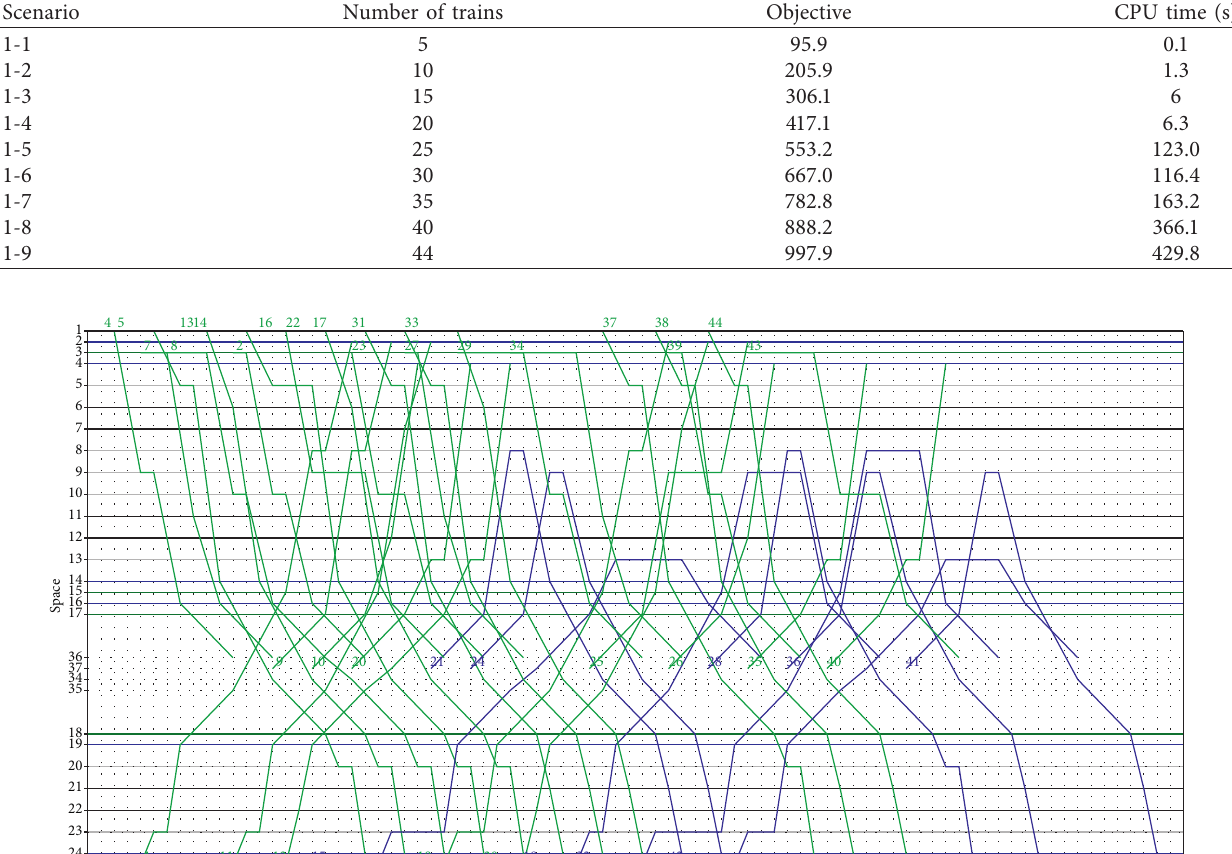
Table 5: Performance comparison with an increase in the number of trains.